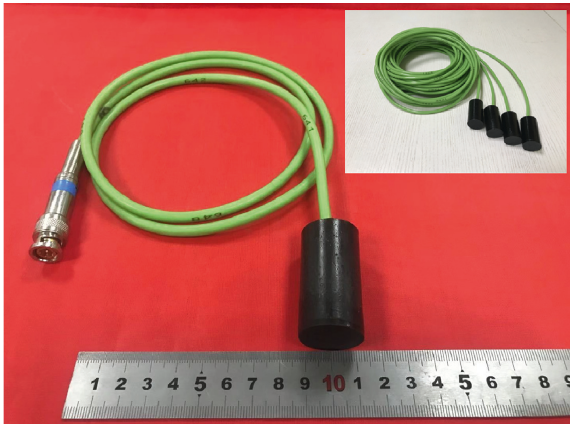
Figure 2: Photos of acoustic emission sensors.